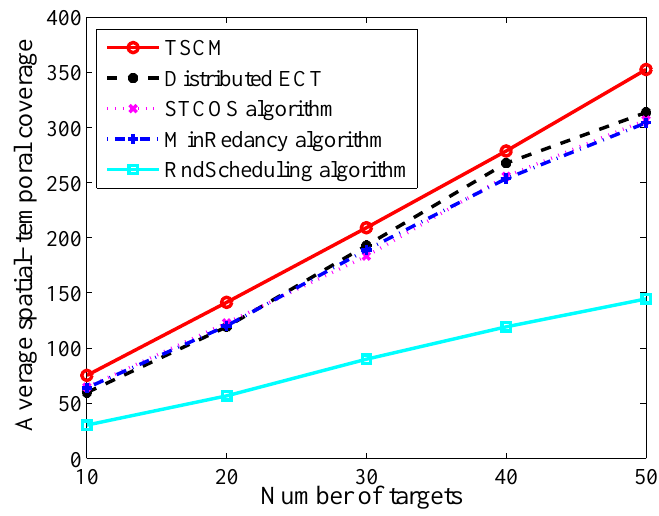
Figure 5. The average spatial-temporal coverage versus different number of targets.